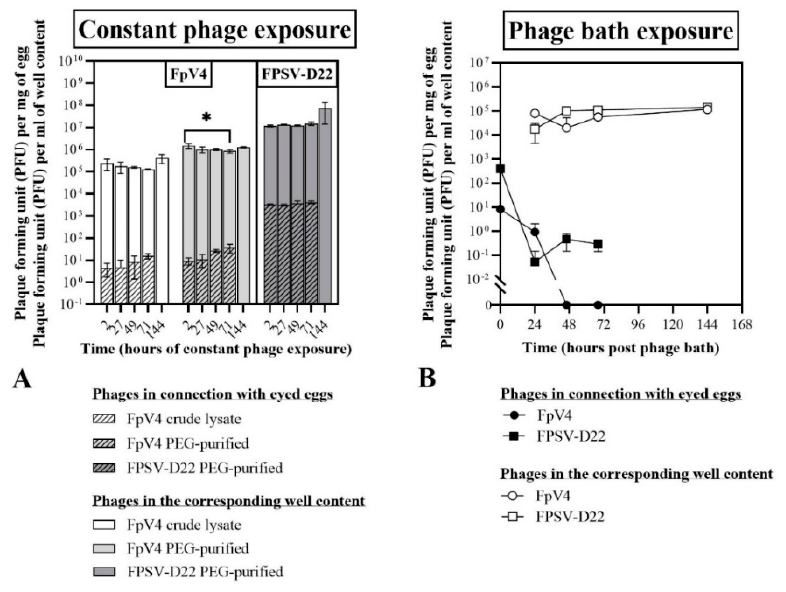
Figure 4. Exp. I and II, section B: phages associated with the eyed eggs and in the corresponding well content ( A ) during constant exposure to phage FpV4 (crude lysate and PEG-purified solutions) and FPSV-D22 (PEG-purified solution) and ( B ) after a 4 h bath exposure to phage FpV4 and FPSV-D22 (1.9 × 10 7 PFU mL − 1 FpV4 or 8.2 × 10 7 PFU mL − 1 FPSV-D22; crude lysates). Values represent the mean and standard deviation of three biological replicates. At 144 h, phages were quantified only for the well content. In A , * = statistically significant differences between the concentration of phages detected at 2 and 71 h in connection with eyed eggs (adjusted p = 0.0184) and in the corresponding well content (adjusted p = 0.0256). No other statistically significant differences were detected between phage concentrations within each group ( A ).